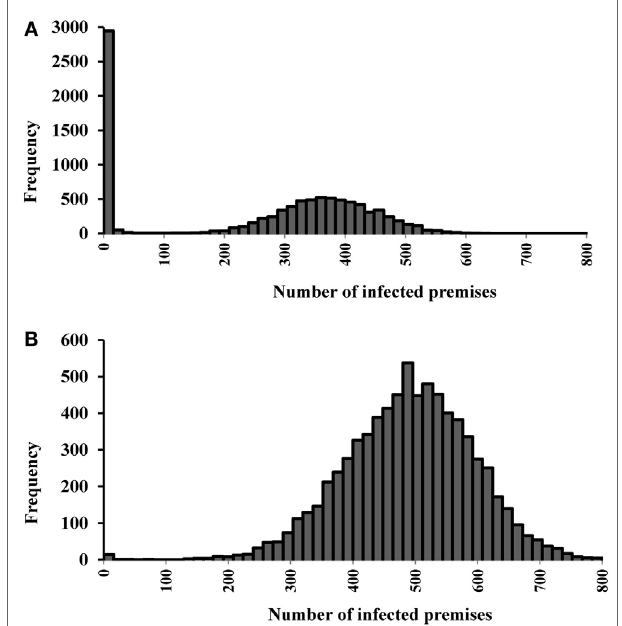
FigUre 4 | histograms of the number of infected premises estimates for (a) 19 most likely single-site classical swine fever outbreak scenarios ( N = 9,500 iterations). (B) 15 most likely multiple-site outbreak scenarios ( N = 7,500